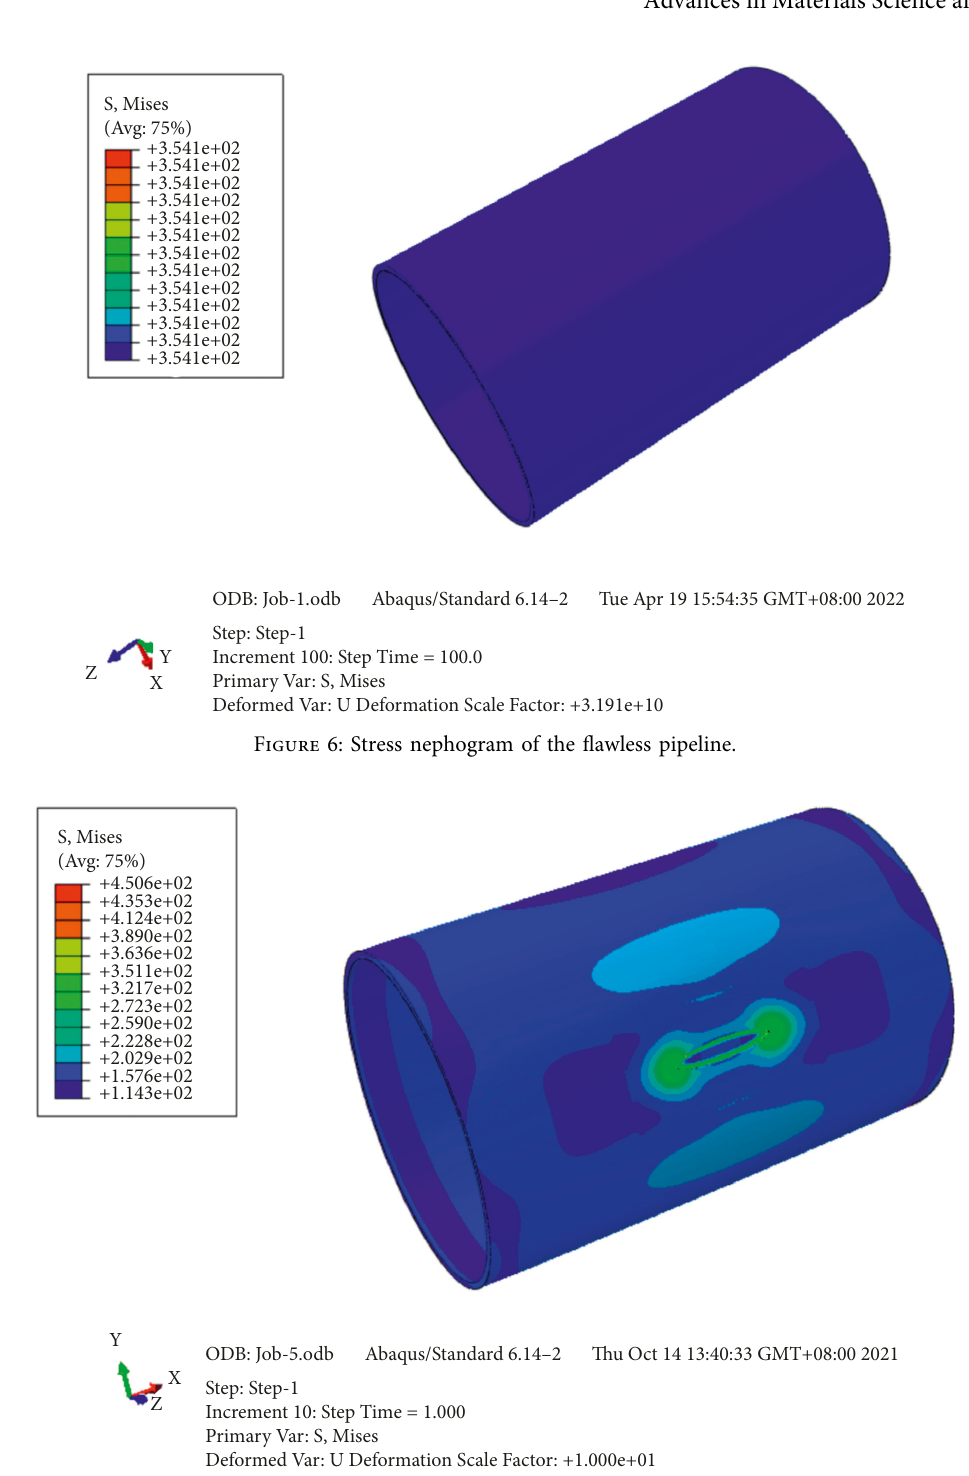
Figure 7: Stress nephogram of the defective pipeline under actual working conditions.